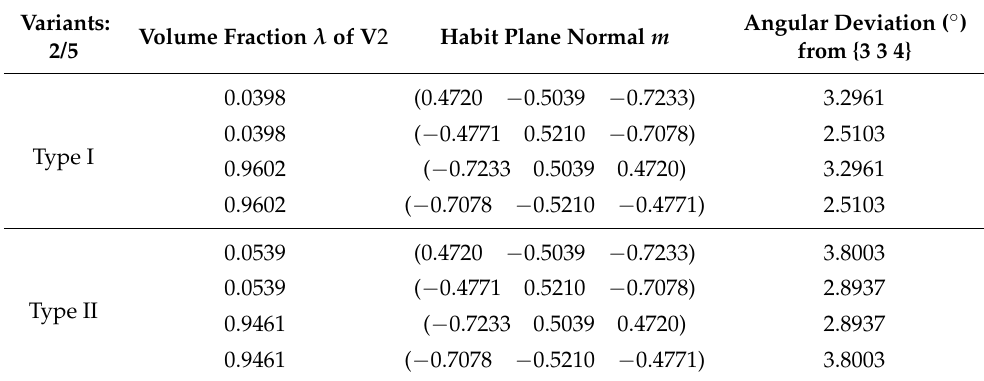
Table 5. Predicted variant volume fraction, habit plane normal and angular deviation from experi- mental result